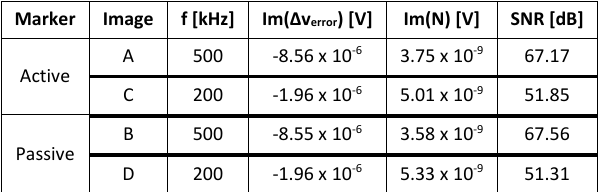
Table 4: Some quantitative data on the signal errors Im(Δ v erorr ) in figure